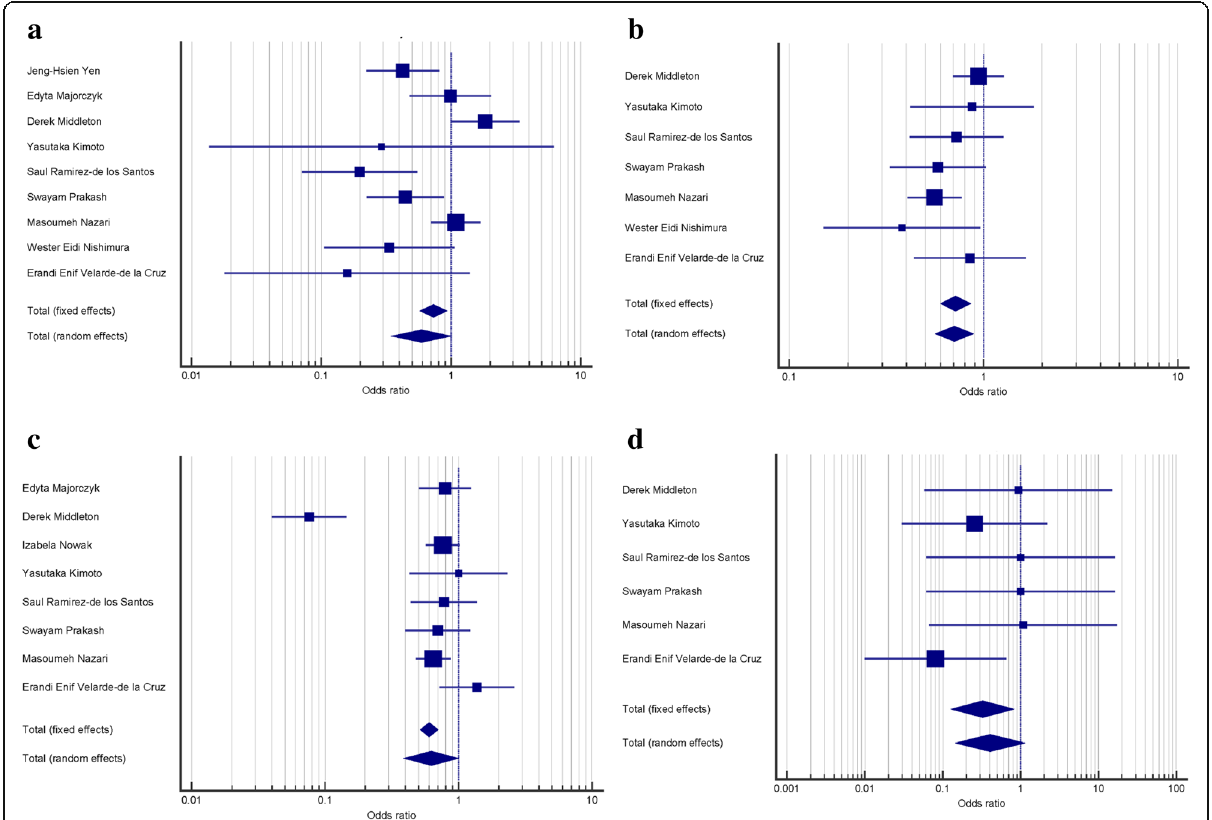
Fig. 2 Forest plot. The plot shows results of pooled OR for ( a ) 2DL3, ( b ) 2DL5, ( c ) 2DS5, and ( d ) 3DL3